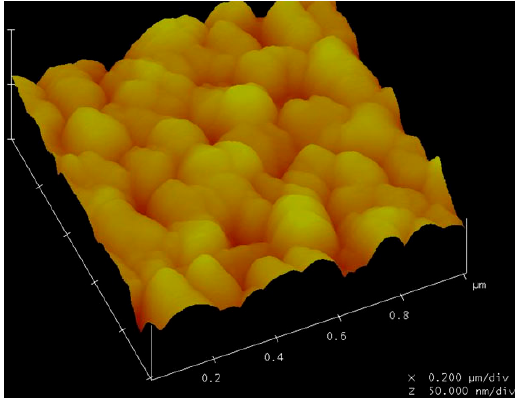
Figure 9. AFM image obtained from rabbit IgG receptor surface. Relatively uniform surface morphology was observed.